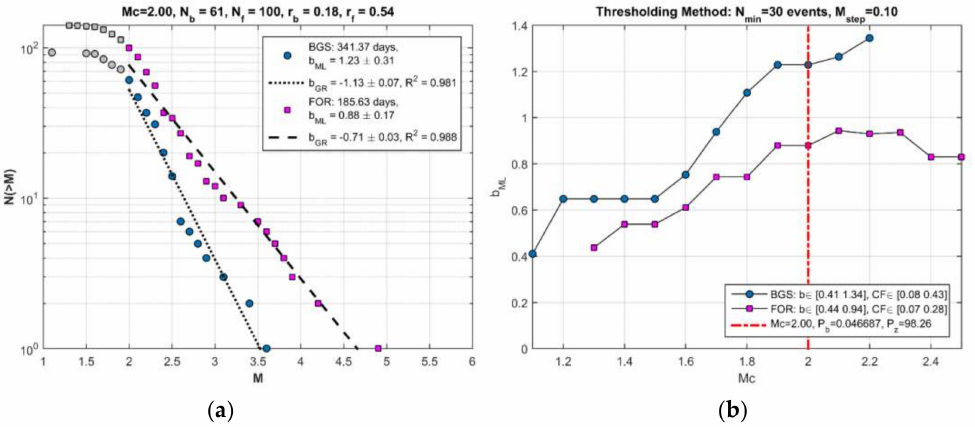
Figure 14. As in Figure 9 for the periods of background seismicity BGS 2 and FOR-cluster 2 ( a ). The b-value in BGS 2 is significantly higher than that in FOR period. This is systematically valid for M c varying from 1.1 to 2.2 with step 0.1 ( b ). For M c = 2.0 (vertical red line) the di ff erences in b are higlhy significant (see Section 3.2.1). Seismicity testing showed that the FOR period (cluster 2) represents a typical foreshock sequence (see Section